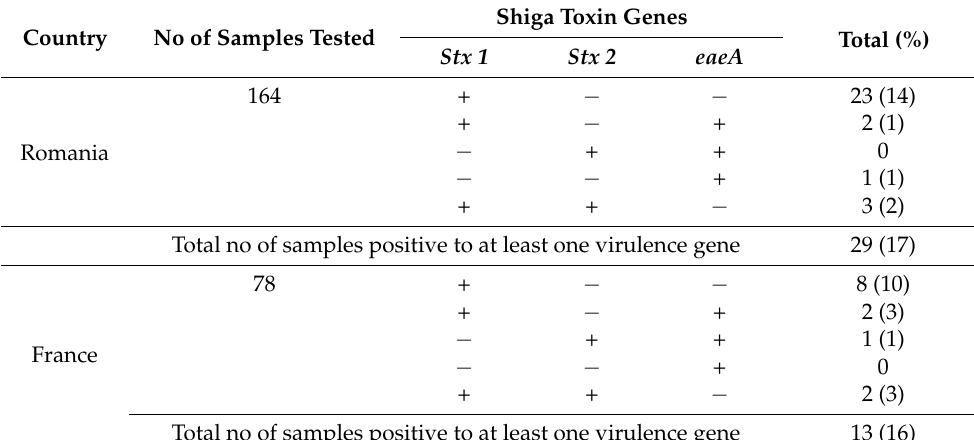
Table 1. Toxin gene presence in positive E. coli